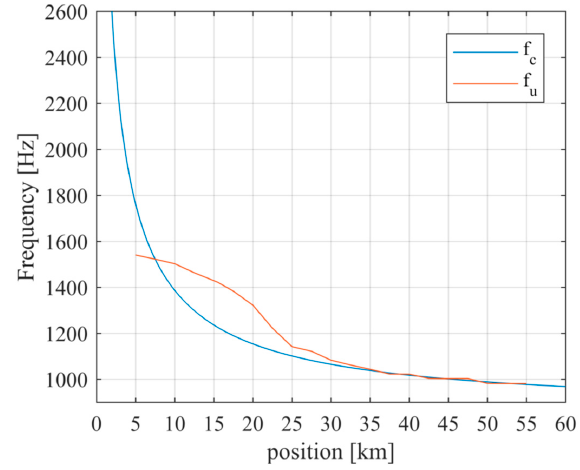
Figure 6. Comparison of "measured" frequency simulated by EMTP-rv and frequency calculated by a lumped parameter circuit.